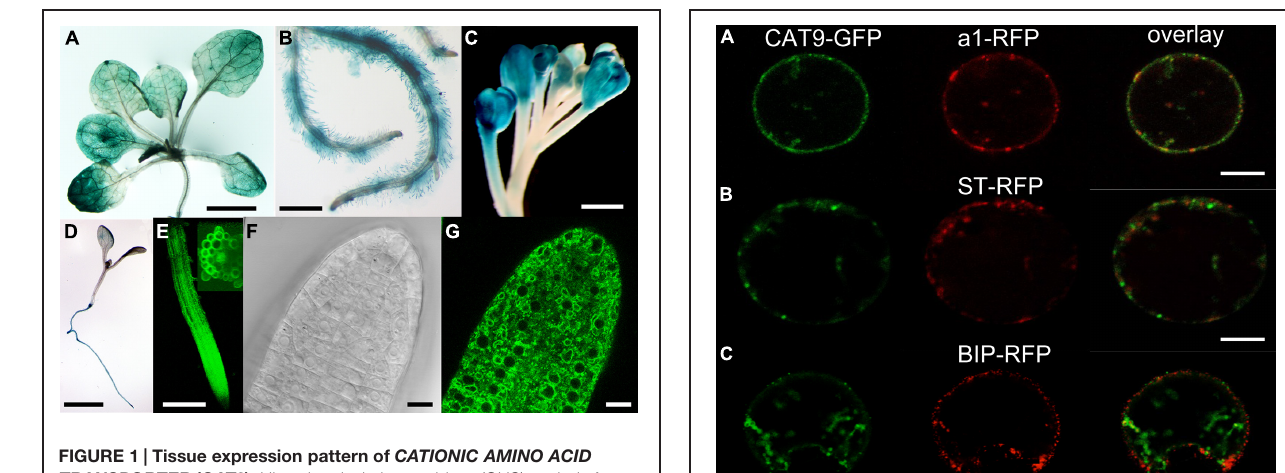
dye is incorporated rapidly via endocytosis into vesicular struc- tures (Dettmer et al., 2006). Furthermore, part of the